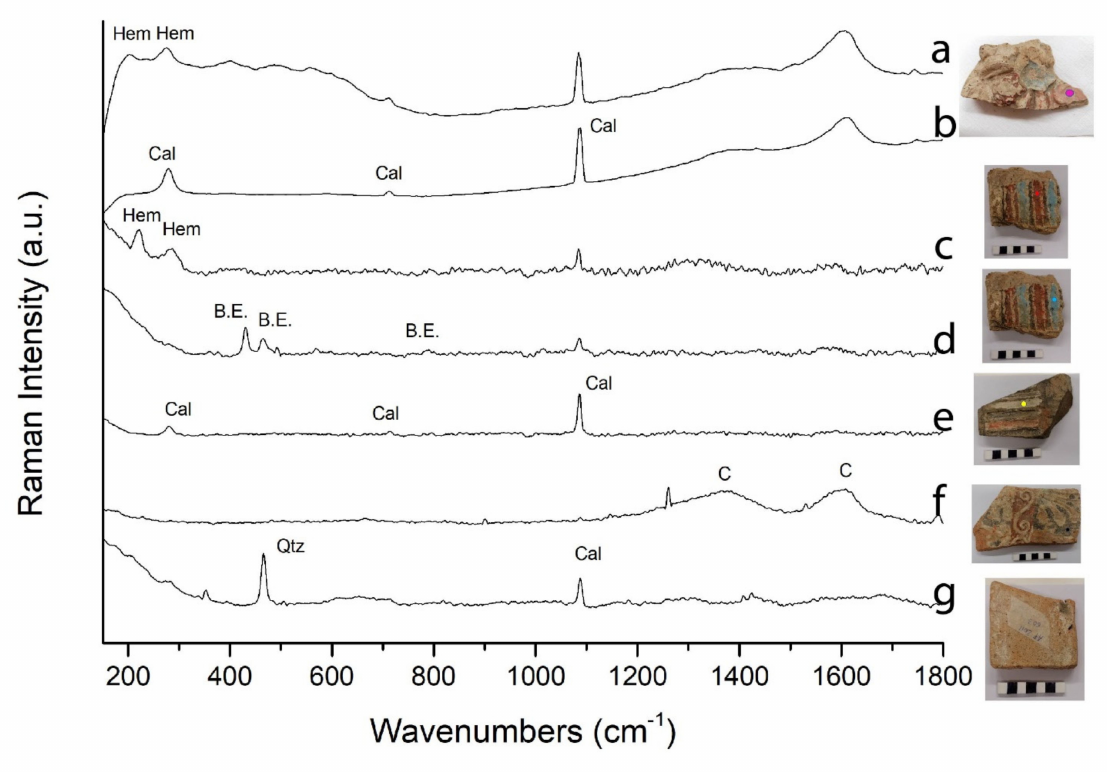
Figure 3. µ -Raman spectra of the Alba Fucens samples and relative peak identification (compound ab- breviations: Cal-calcite; Hem-hematite; Qtz-quartz; B.E-Egyptian blue [CaOCuO(SiO 2 ) 4 ]; C-carbon). ( a ) Pink pigment layer; ( b ) background of pink pigment; (c) red pigment layer; ( d ) light blue pigment layer; ( e ) white pigment layer; ( f ) black pigment layer; ( g )